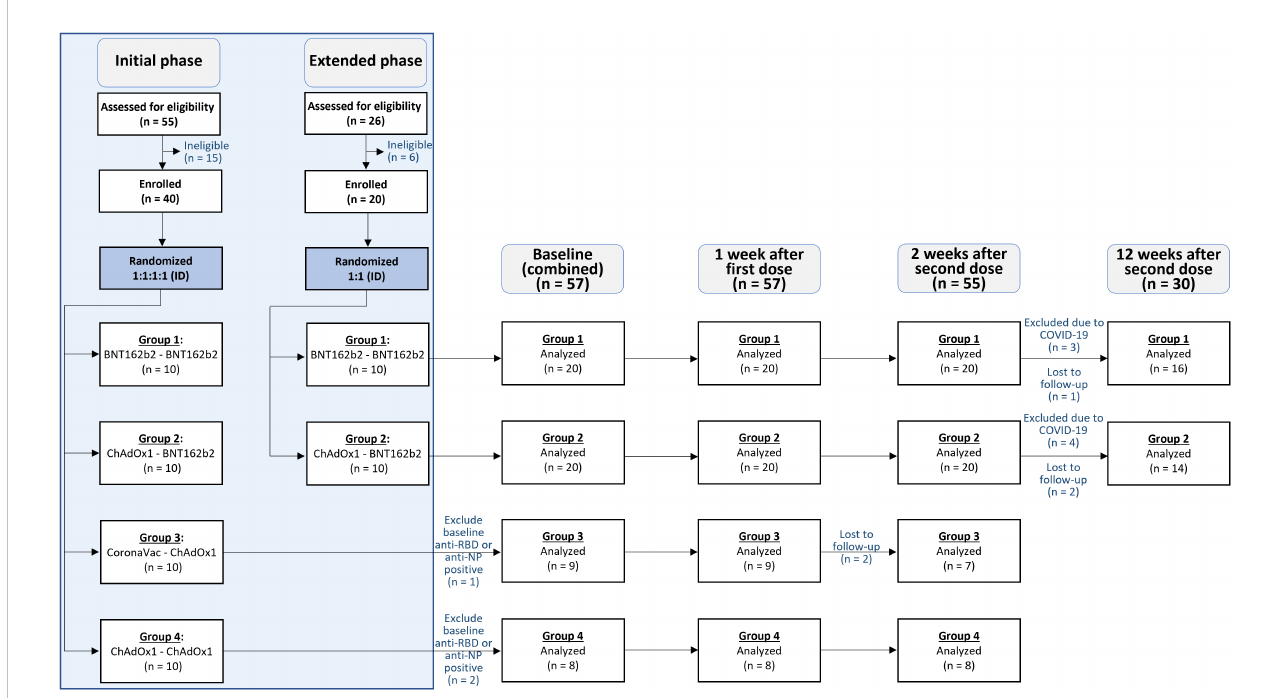
randomized (1:1) into two of the four accelerated intradermal vaccine regimens. Participants were assessed thereafter at baseline (n = 57), 1 week after the fi rst dose (n = 57), 2 weeks after the second dose (n = 55), and 12 weeks after the second dose (n